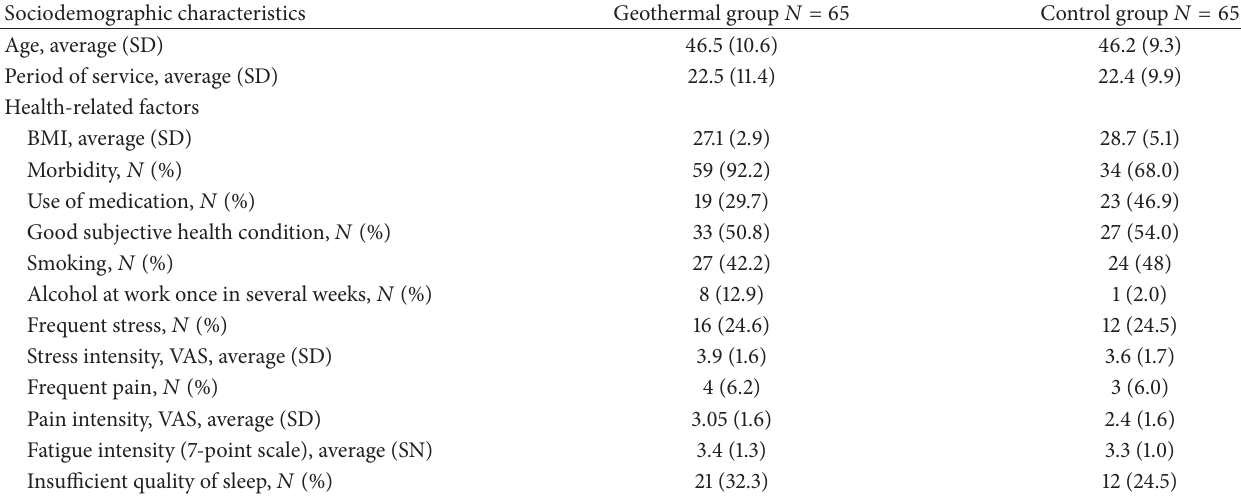
Table 2: Demographic and basic clinical characteristics of the